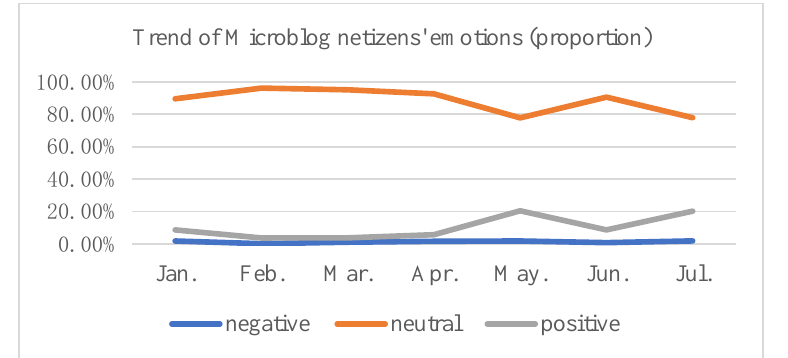
Fig. 3. Trend of Microblog netizens' emotions (proportion).